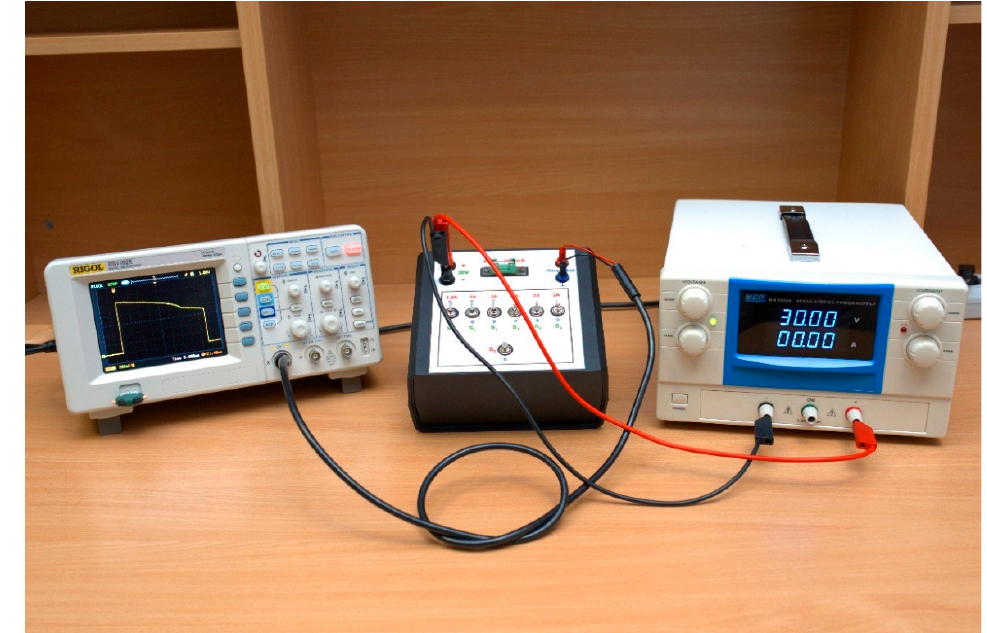
Figure 1. View of a test bench for implementing the destructive tests of miniature fuses.